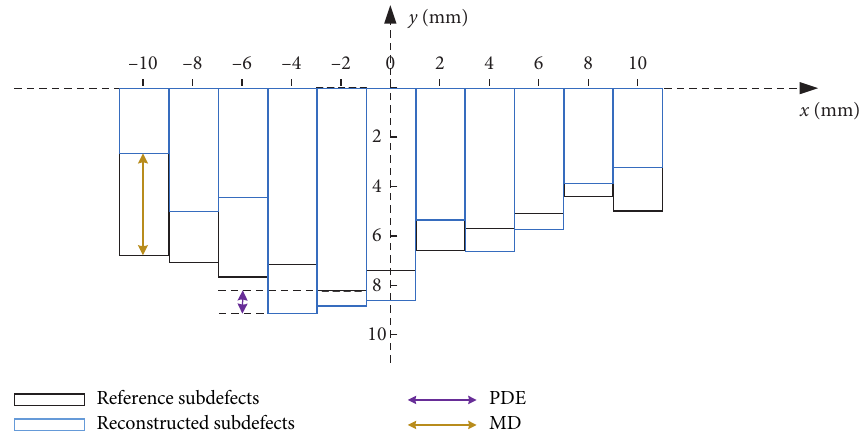
Figure 8: Illustration of PDE and MD.